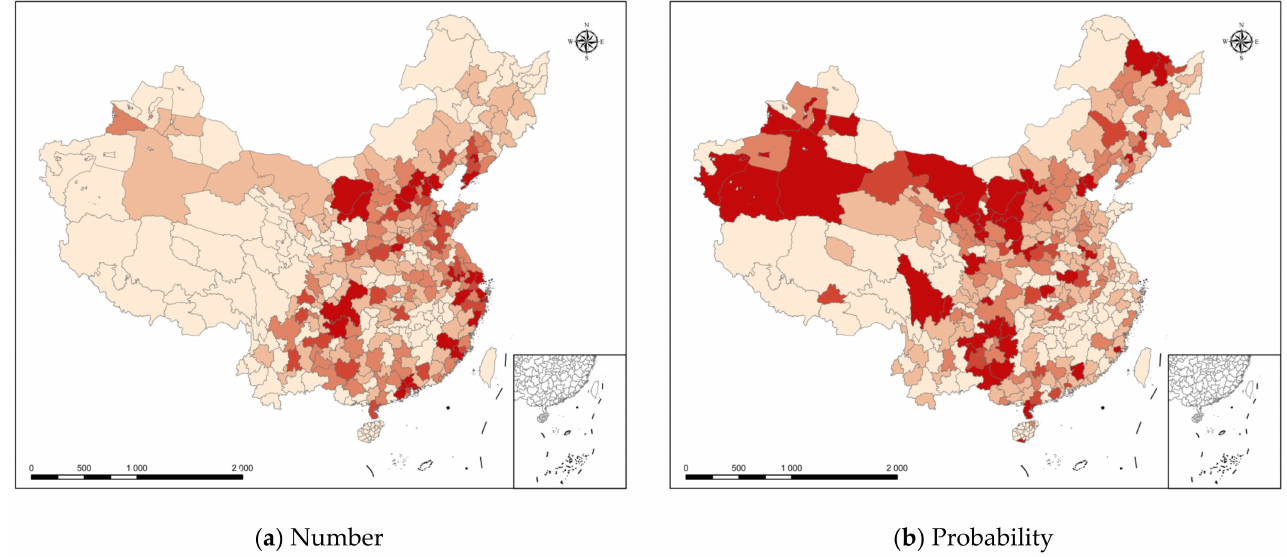
Figure 4. Spatial Distribution of Polluting Enterprises Exiting the